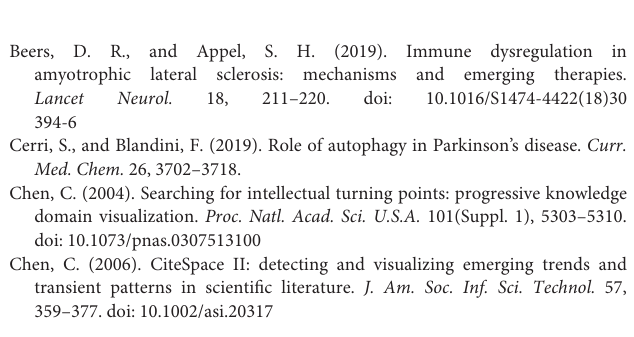
Supplementary Figure 1 | The number of Publications and citations in TFEB research. Supplementary Figure 2 | The dual-map overlay of journals related to TFEB research. Supplementary Figure 3 | The network map of countries/regions that involved in TFEB research. Supplementary Figure 4 | The network map of institutes that involved in TFEB research. Supplementary Figure 5 | The network map of active authors contributed to TFEB research. Supplementary Figure 6 | The co-citation map of authors contributed to TFEB research. Supplementary Figure 7 | The co-citation map of references from publications in TFEB research. Supplementary Figure 8 | Top 19 keywords with strongest citation bursts in the part of “diseases.” Supplementary Figure 9 | Top 21 keywords with strongest citation bursts in the part of “signal pathways.” Supplementary Figure 10 | Top 15 keywords with strongest citation bursts in the part of “intervention